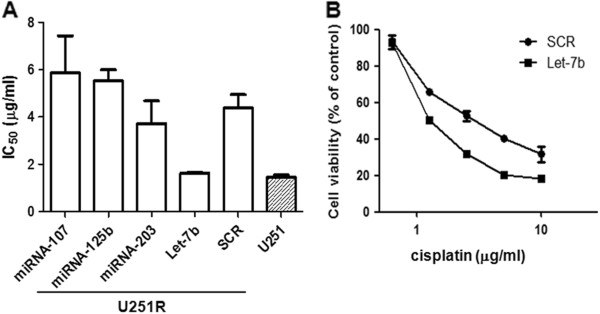
Transfection of Let-7b re-sensitization of the resistant cells. (A) U251R cells were transfected with mimics of miR-107, miR-125b, miR-203, Let-7b or scramble (SCR). Then their IC50 to cisplatin was determined. U251 parental cells were used as control. (B) U251R cells were transfected with Let-7b mimics or scramble (SCR), and then the dose–response curves were plotted.